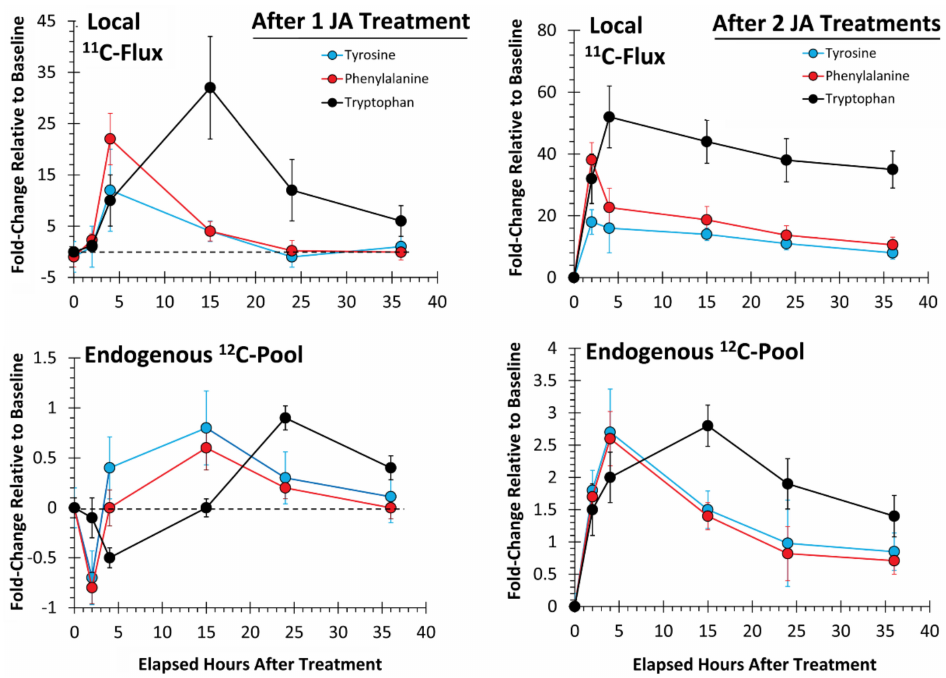
Figure 4. Local tissue responses to 500 µ M JA treatments—partitioning of ‘new’ carbon (as 11 C) into tyrosine, phenylalanine and tryptophan is presented after a single mock treatment and after sequential JA treatments (top panels). Change in the endogenous levels ( 12 C) of these amino acids (AAs) is presented in the bottom panels. Data (N = 3) reflect the fold-change relative to baseline ± SE at timepoints 2, 4, 15, 24 and 36 h